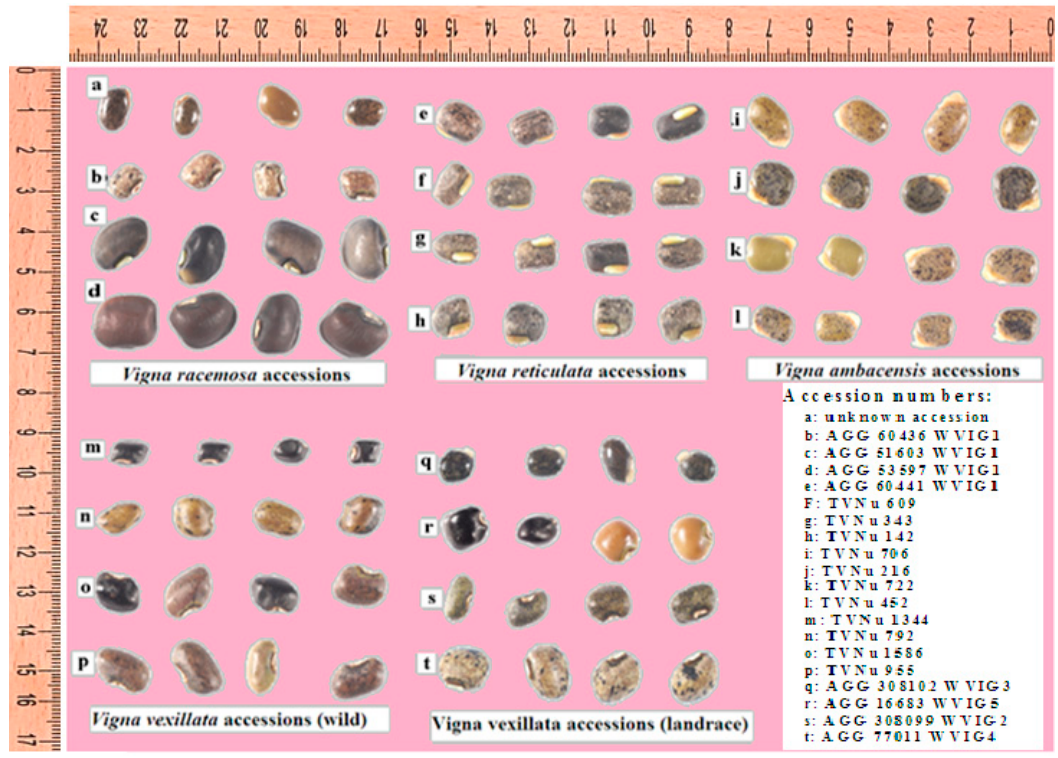
Figure 1. Photographs illustrating seed morphology of wild Vigna species. Four seeds per accession were pictured under the same conditions to give an image of the morphology and the relative size. Distances of lines in the background are 1 cm in the vertical and horizontal directions. Source: